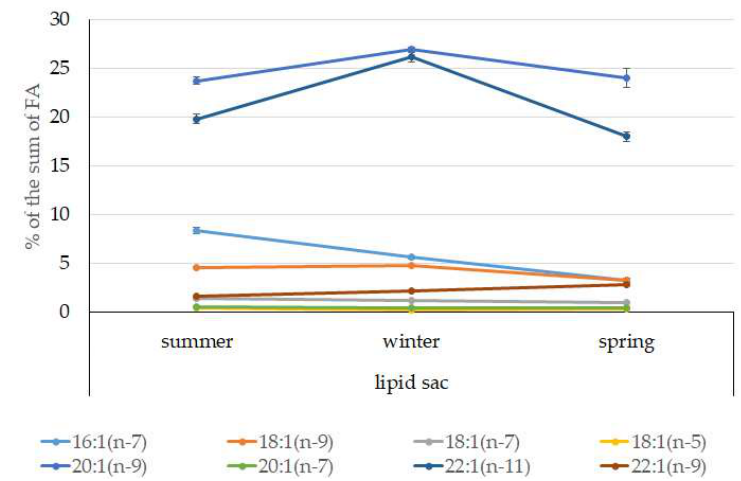
Figure 11. Seasonal dynamic of certain MUFA levels (% of the sum of FAs) in the lipid sac in postlarval (L3 developmental stage) daubed shanny from Kongsfjord. The data presented as M ± SE.